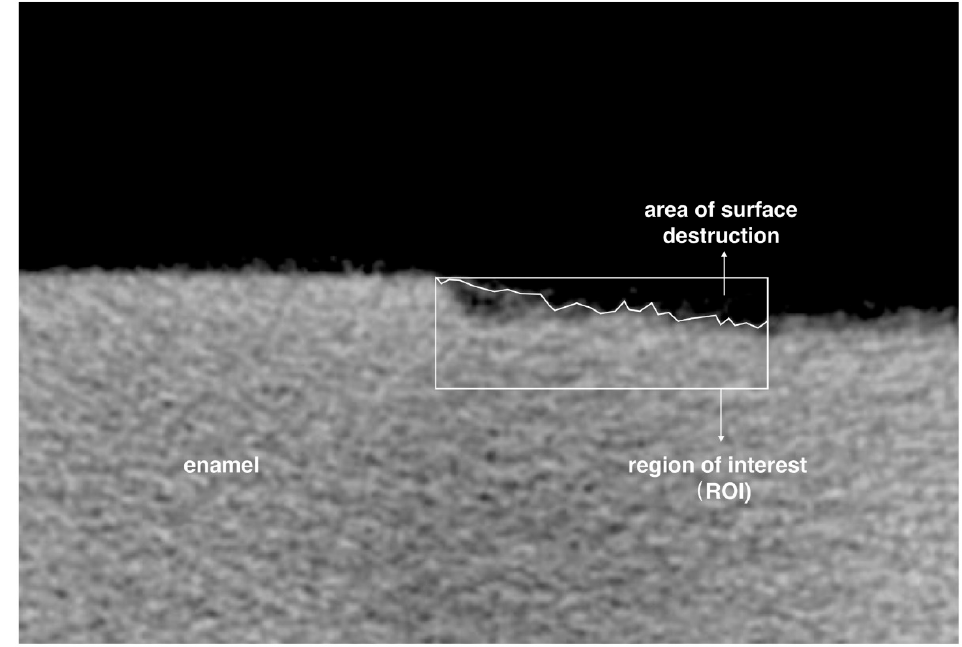
Figure 3. Illustration of choosing surface destruction area. Surface destruction percentage = area of surface destruction/area of region of interest.